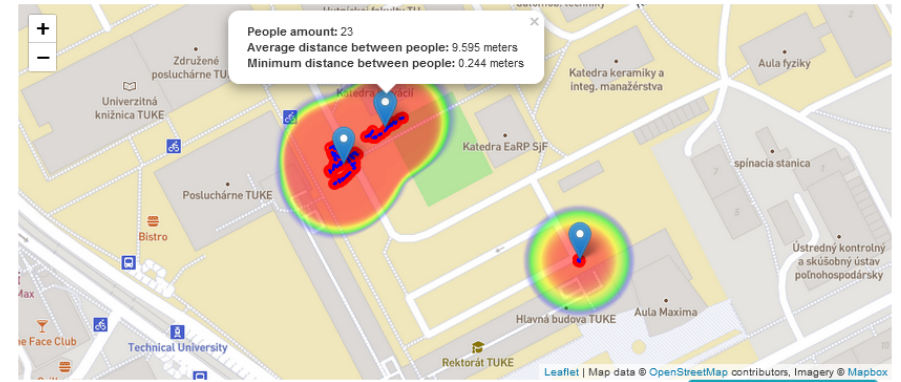
Figure 6. Cluster analysis using K-means algorithm.